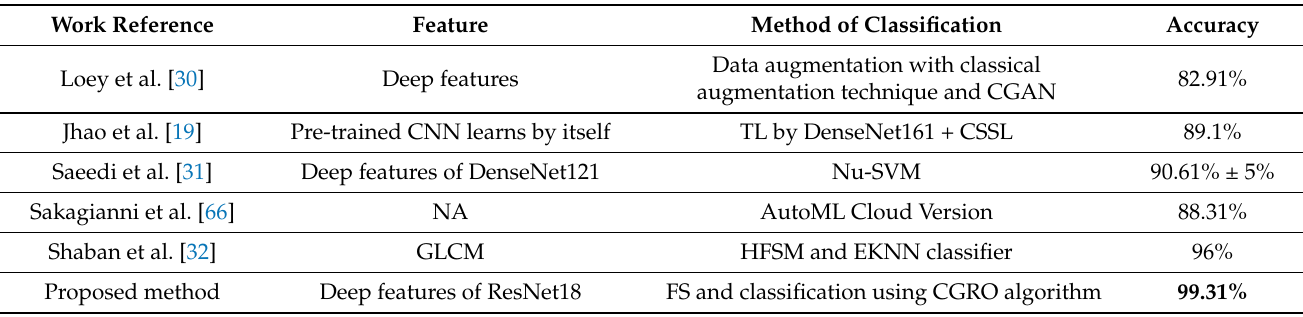
Table 10. Performance comparison of our proposed approach with some existing works for COVID CT-Dataset. Maximum value is bolded.